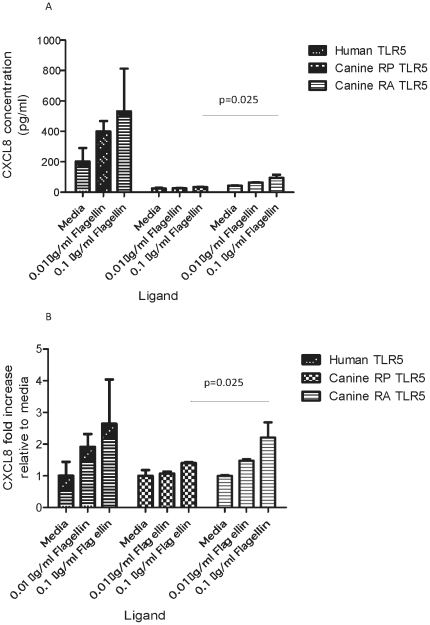
Activation of CXCL8 secretion in stimulated HEK 293 cells stably transfected with human TLR5, canineTLR5RP-YFP or canineTLR5RA-YFP.Transfected human TLR5, canineTLR5RP-YFP and canineTLR5RA-YFP HEK 293 cells were incubated with flagellin or media for 24 hours before production of CXCL8 was analysed by an ELISA. The results displayed are the mean values of one experiment with three repeats under the same conditions, with error bars illustrating standard error of the mean. Data are presented either as concentration (pg/ml) (A) or converted into fold-increase by comparing to the concentration obtained for unstimulated cells with media (B). The CXCL8 production was significantly higher in canineTLR5RA-YFP cells than in canineTLR5RP-YFP cells when stimulated with the higher flagellin concentration (0.1 µg/ml) (p = 0.025, one-tailed).